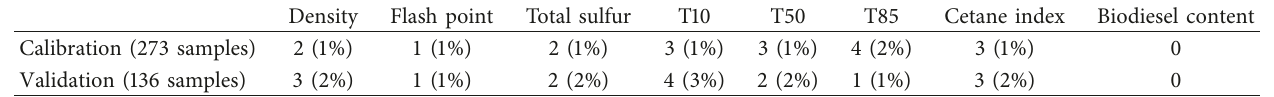
Table 4: The number of outliers removed from the calibration and validation